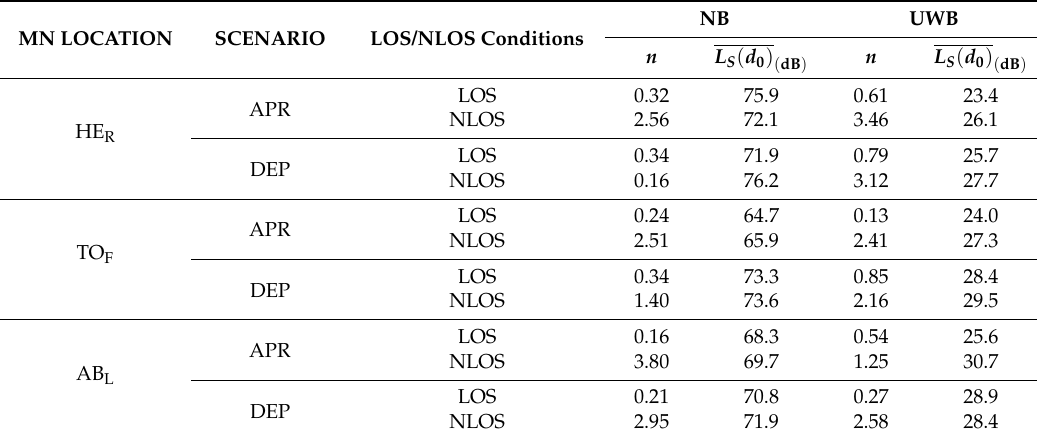
Table 1. Obtained values of SLE and MSL at reference